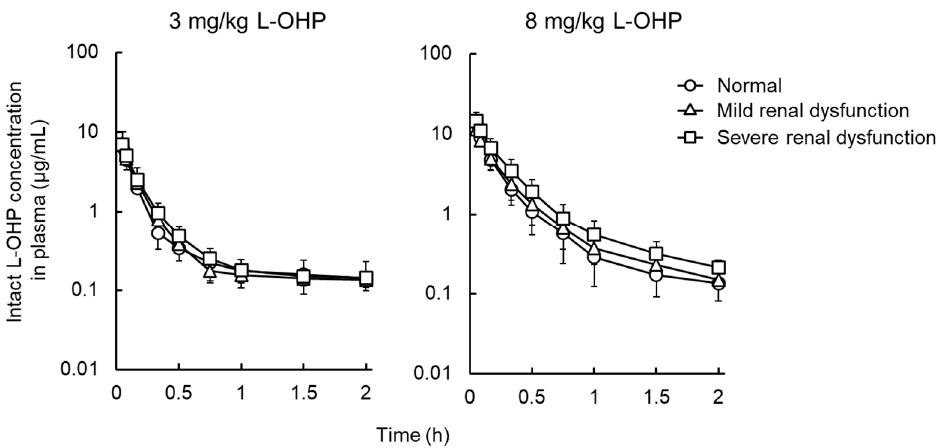
Figure 1. Mean plasma concentration profiles of oxaliplatin (L-OHP) after intravenous administration of 3 or 8 mg/kg of L-OHP. Each symbol represents normal ( ○ ), mild ( △ ), or severe renal dysfunction ( □ ) groups. Each point shows the mean ± S.D. ( n = 4–5).